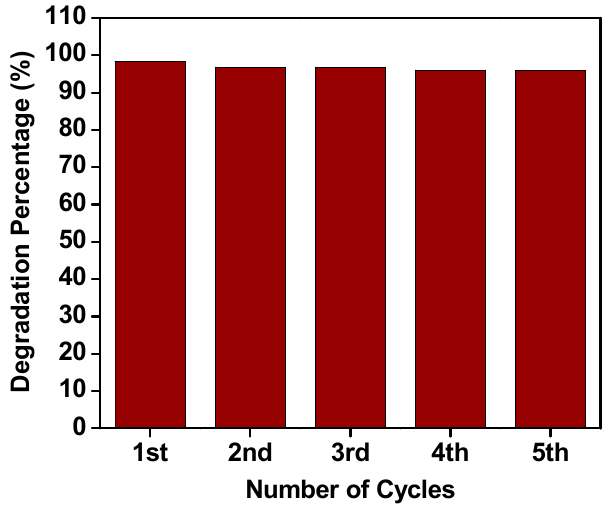
Figure 9. Recyclability test of the PZ ‐ 17 film in the photocatalytic degradation of MO. [MO] = 10 mg/L; pH = 5.8; quantity of films = 2. Table 4. The amount of MO degraded in 5 consecutive cycles using the PZ ‐ 17 film photocatalyst.